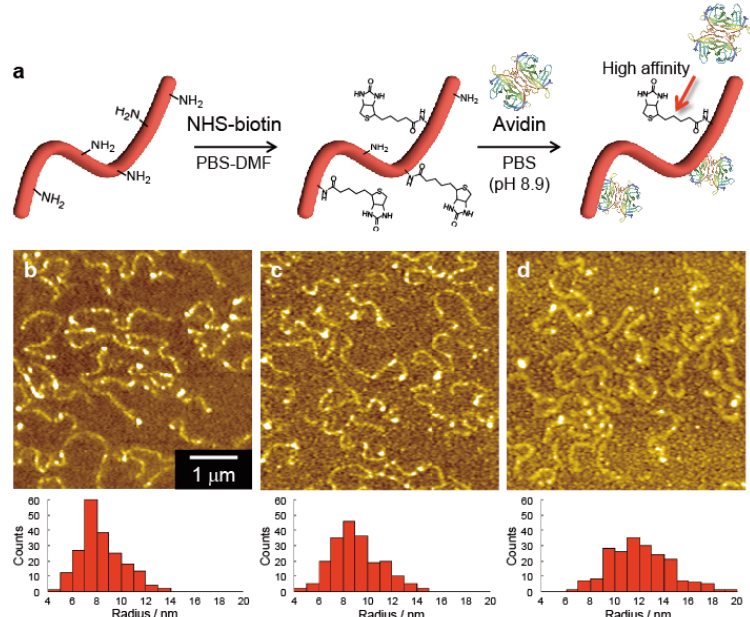
Figure 7. ( a ) Scheme showing the surface modification of HSA nanowires by introducing biotinyl groups and the affinity between biotinylated HSA nanowires and avidin. AFM images and radius distributions of ( b ) HSA nanowires, ( c ) biotinylated HSA nanowires, and ( d ) biotinylated HSA